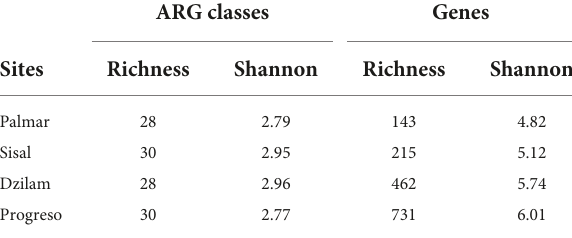
TABLE 2 Richness and diversity index (Shannon) of antibiotic resistance gene (ARG) classes and genes by sampling